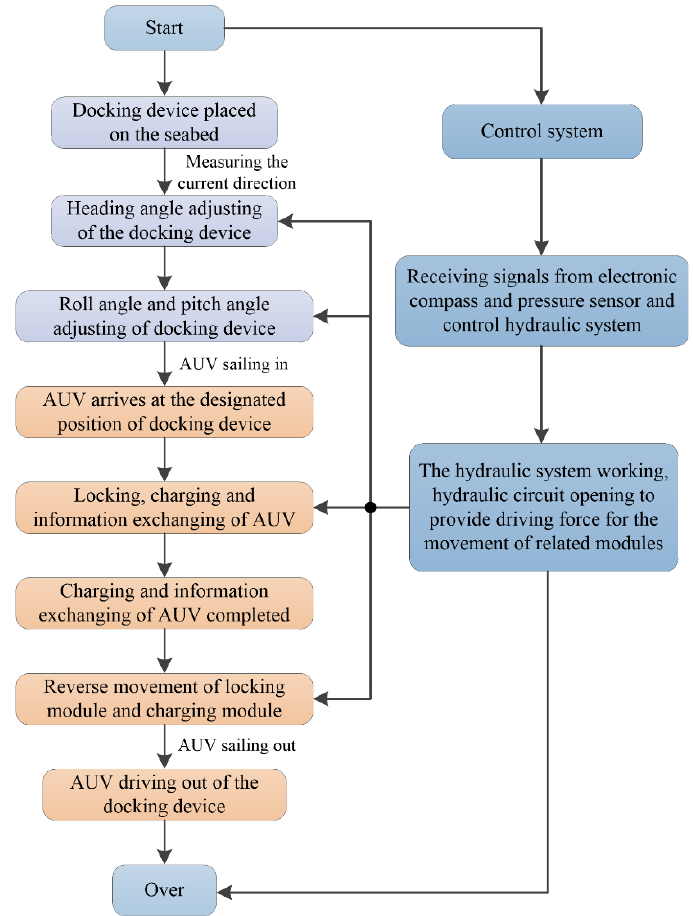
Figure 4. Docking flow chart of the AUV and the designed docking device.